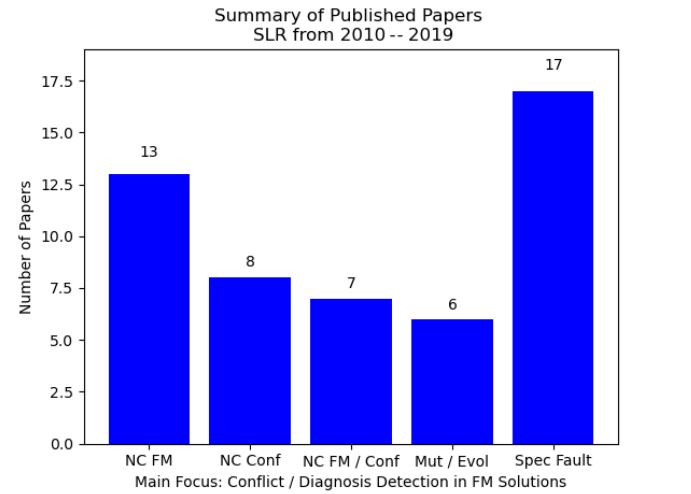
Figure 6. Summary of published papers for the conflict detection, diagnosis and product completion from 2010 to